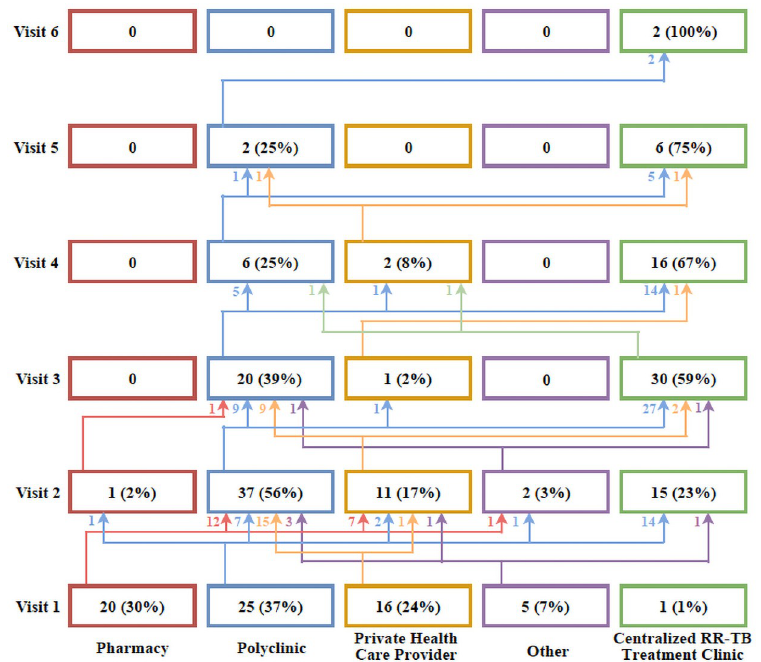
Fig 3. Different Health care facilities attended by study participants and the proportion (%) of participants attending each facility as a proportion of all health care visits for each health care visit (Visit 1–6). Different colours correspond to the health facility where patients sought care while different arrows represent successive care- seeking visits. � Four patients were admitted to hospital on first contact with the health system and are not included in this figure.